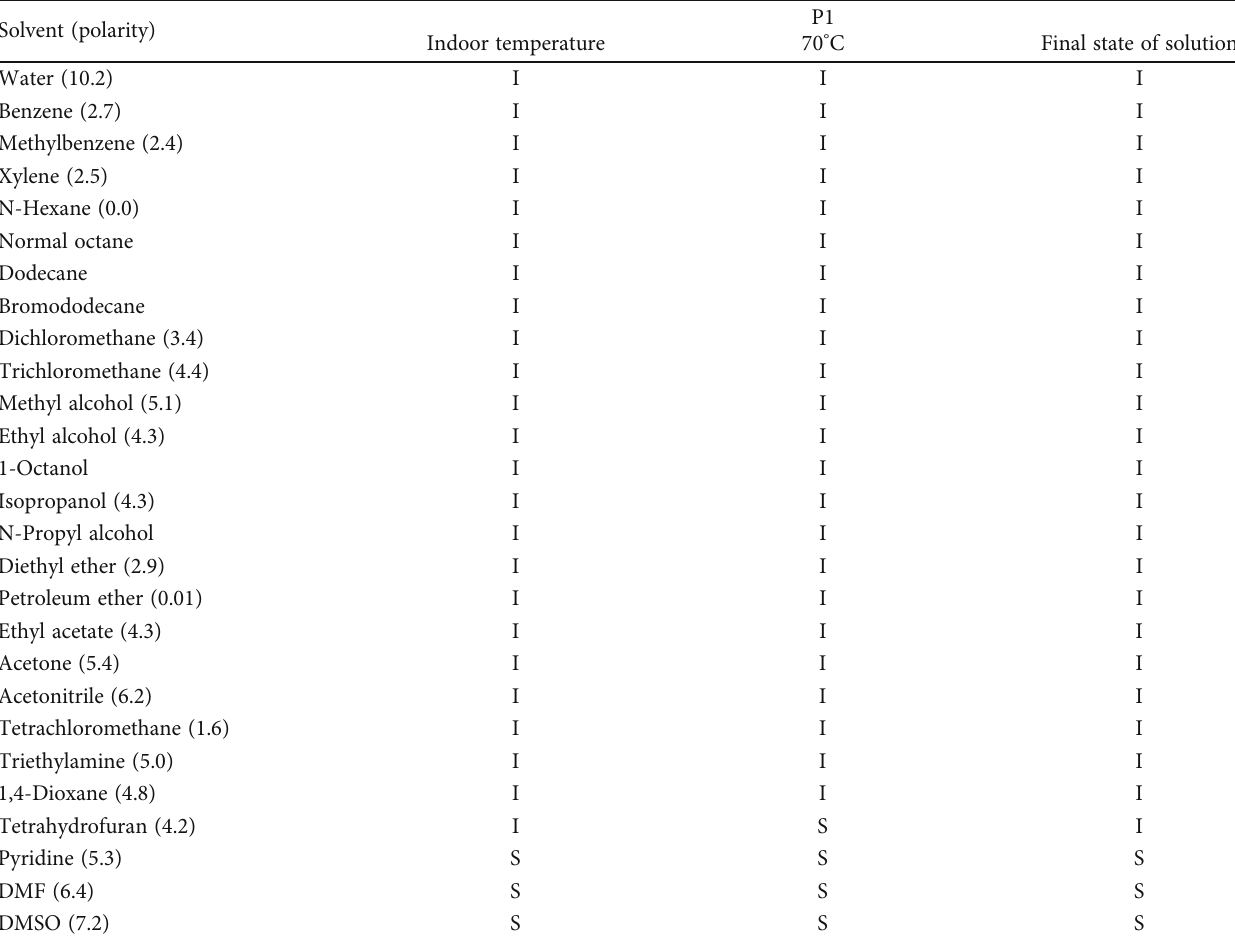
Table 9: Solvent gelation behavior of P1 in di ff erent organic